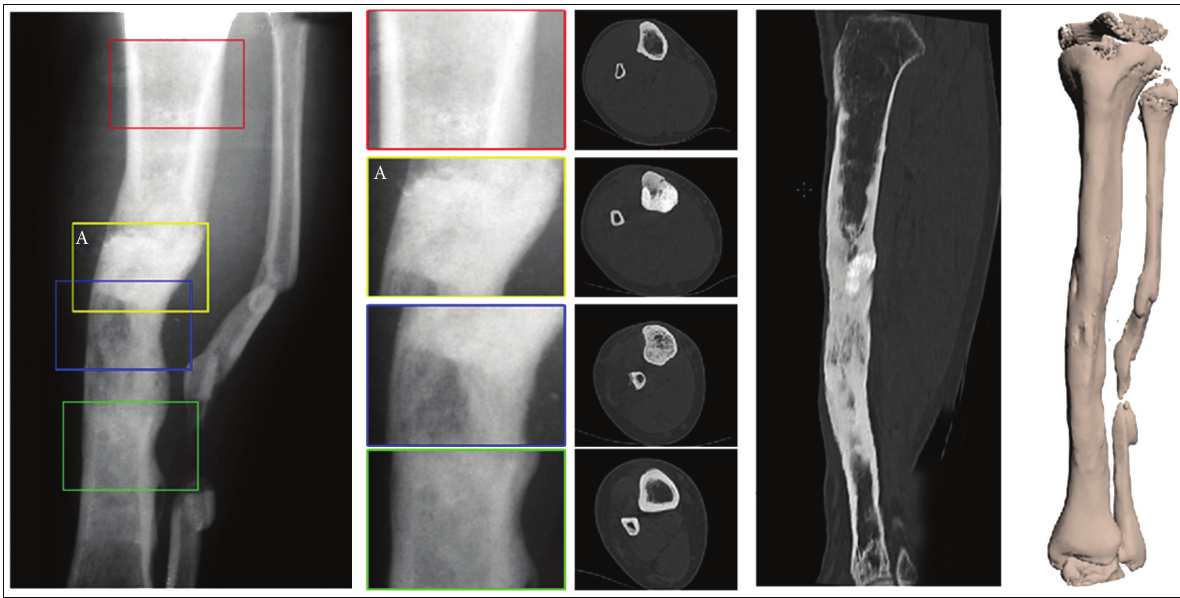
Figure 3: Bone lengthening in an area previously reconstructed with BCP. X-Ray and CT images of a tibia showing the zone reconstructed with BCP (A) and the new bone formed after osteotomy and bone lengthening, which was performed due to the shortening of the limb.